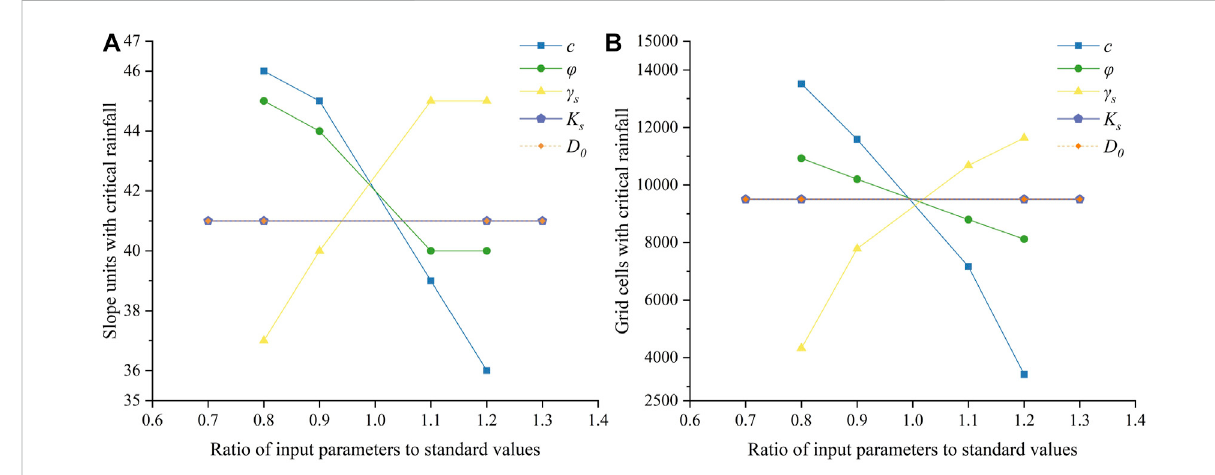
FIGURE 5 The number of objects with critical rainfall (A) slope units and (B) grid cells.